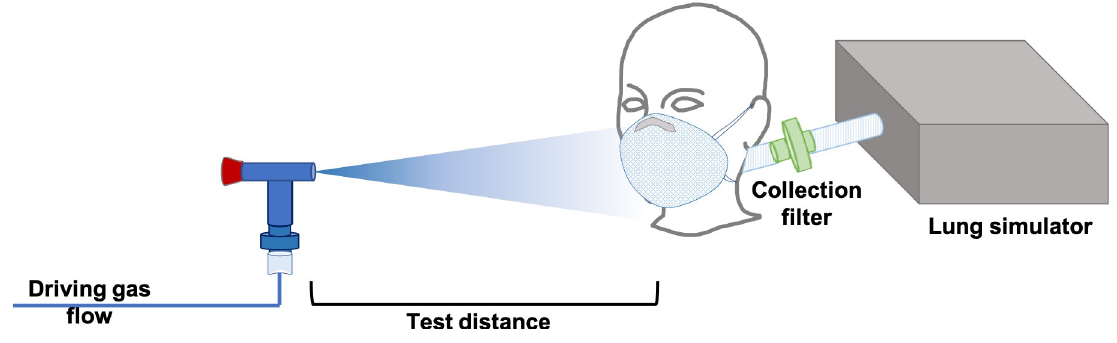
Fig 1. Experimental